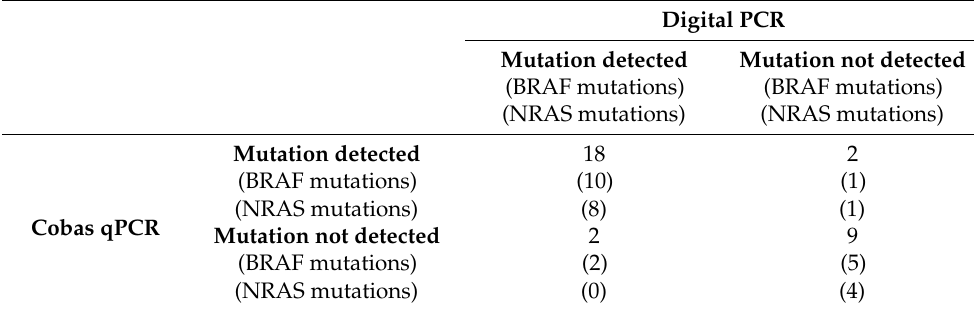
Table 3. Concordance between Cobas analysis and digital PCR for the first 31 patients